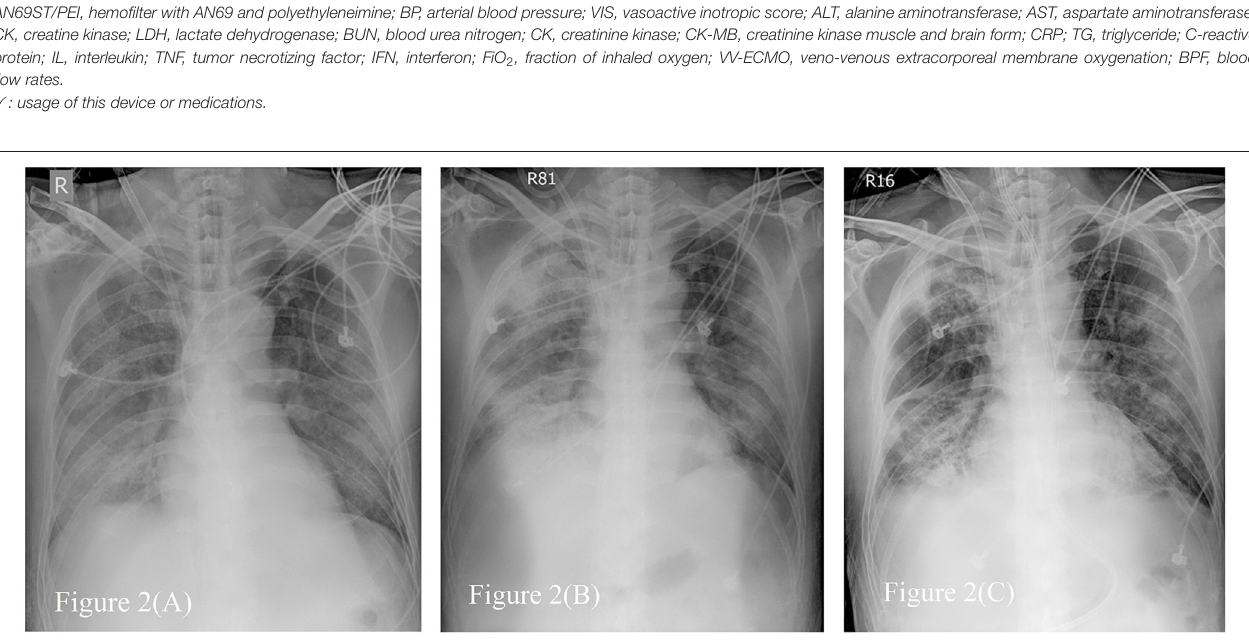
FIGURE 2 | Serial Chest radiographs of the patient. (A) The film showing diffuse alveolar process over bilateral lung field, especially right lower lung field just after extracorporeal membrane oxygenator (ECMO setup). (B) The film revealing consolidation over both lungs when first time we tried to wean from ECMO. (C) The film on the day before removing ECMO, demonstrating fibrotic change as lung filed in (B)